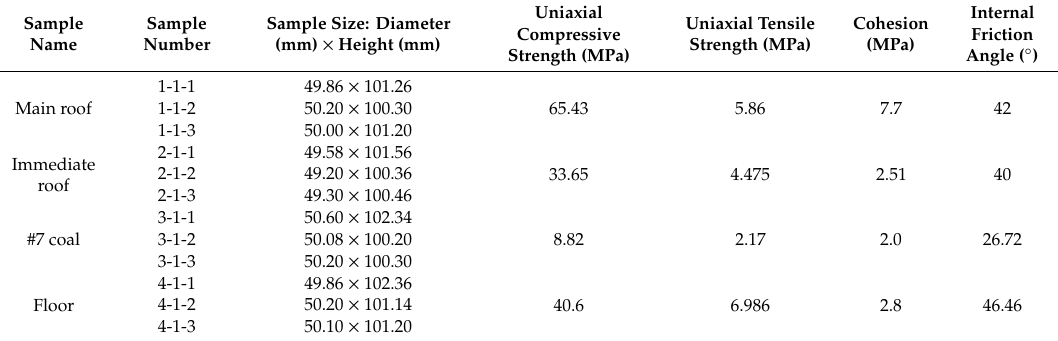
Table 1. Experimental parameters of rock and rock mechanics.